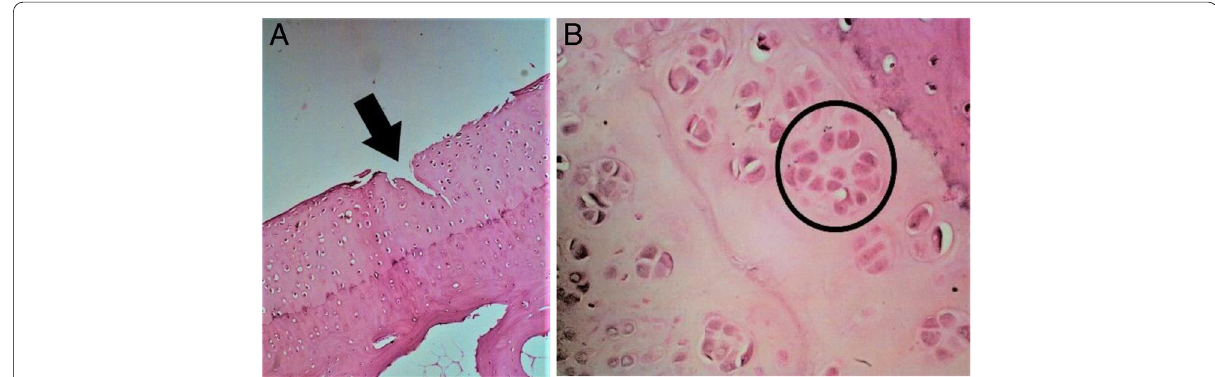
Fig. 3 Microscopic appearance in GH1 group. A Cartilage tear reaching the transitional zone (arrow). B Cell cloning (circle) along with irregular surface of cartilage